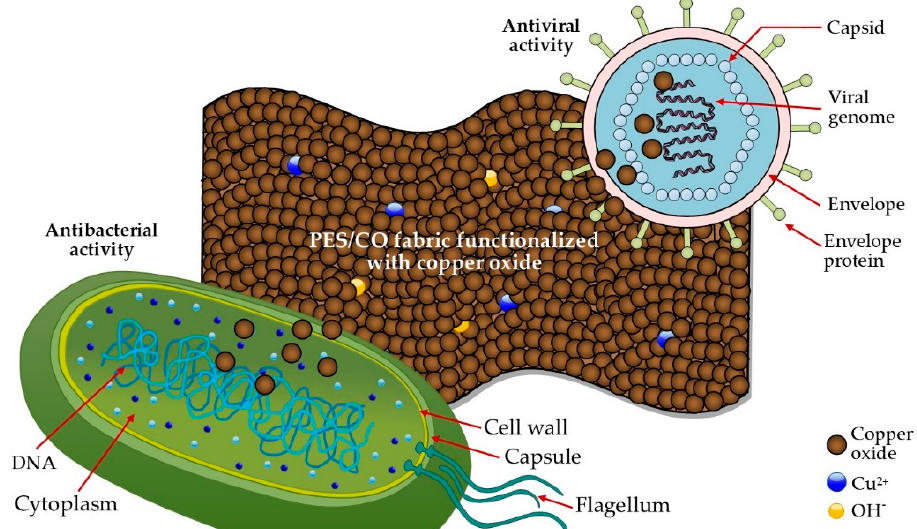
Figure 7. Scheme of the antibacterial and antiviral activity of the PES/CO fabric functionalized with copper oxides.